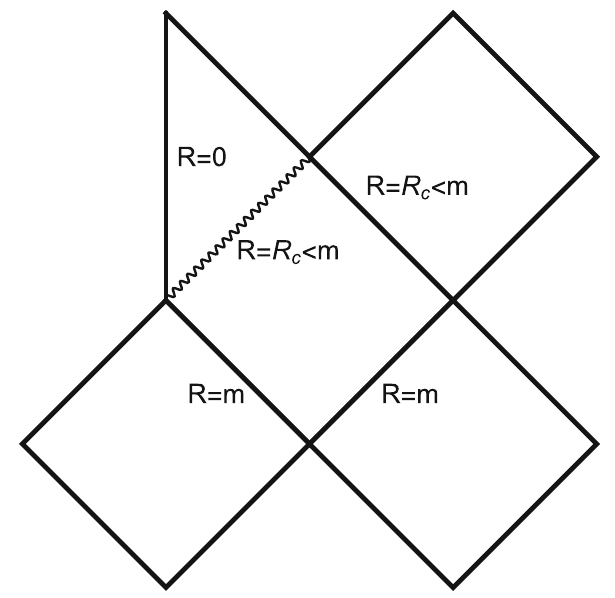
Fig. 7 Conformal diagram of the case m > R c when s = − 1. The diagram repeats itself in the vertical axis indefinitely. The wavy line represents the location of curvature divergences